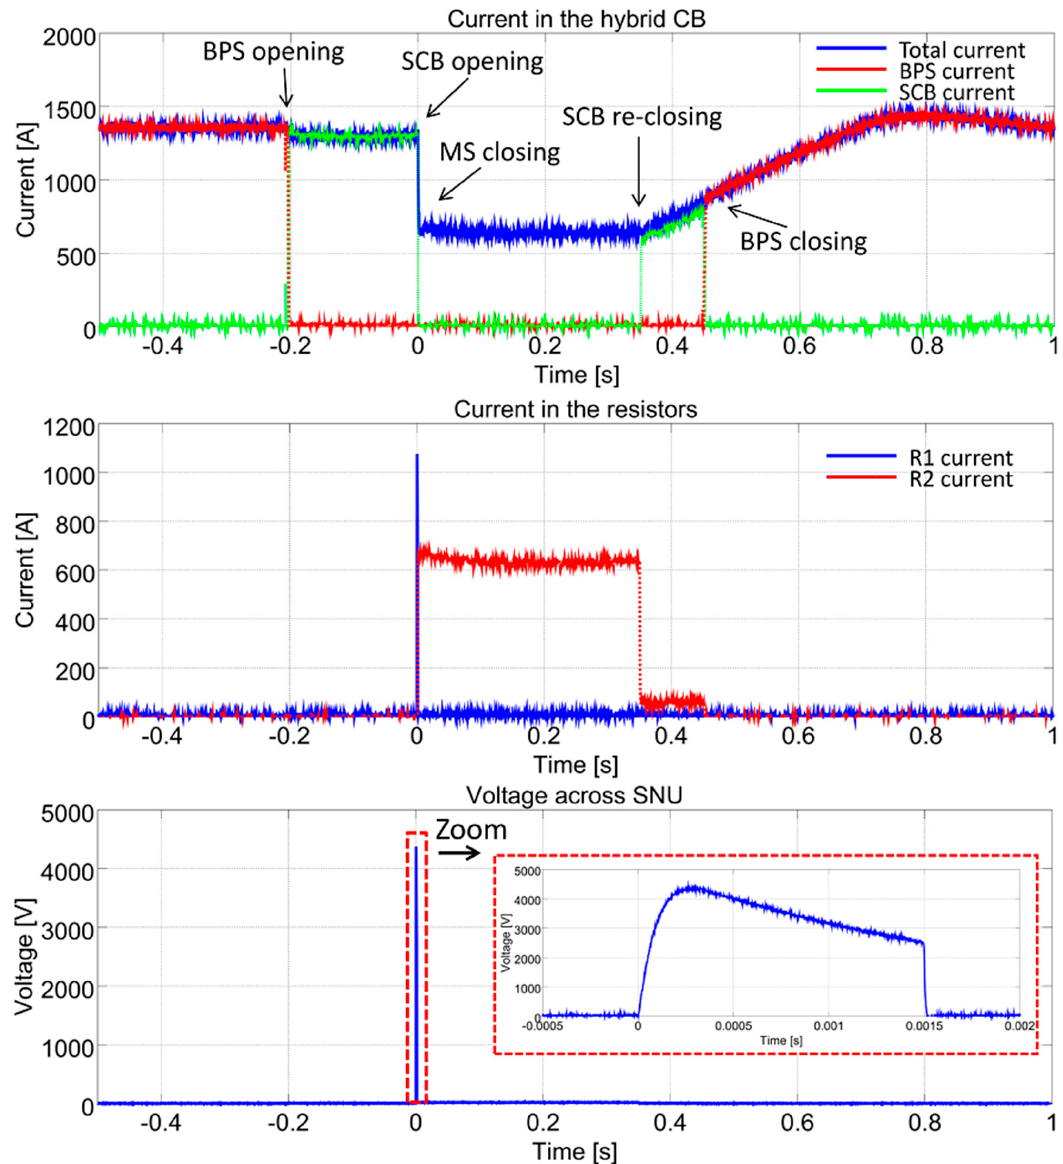
Figure 8. Current and voltage waveforms obtained during the test of SNU CS1 with a R1 value of 3.75 Ω and a R2 value of 25 m Ω .